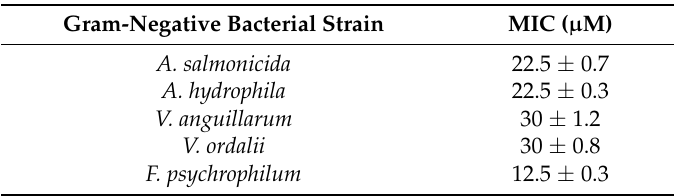
Table 1. Values of minimal inhibitory concentration (MIC) for synthetic cyclotide on different Gram-negative bacterial fish pathogens.